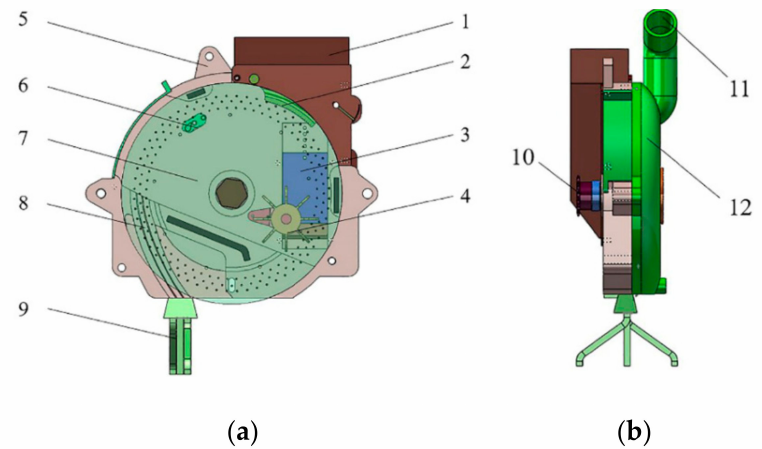
Figure 2. Structural diagram of the metering device: ( a ) Front view; ( b ) Lateral view. 1. Seed box, 2. Outer seed-cleaning device, 3. Retaining tray, 4. Seed stirring wheel, 5. Front housing, 6. Inner seed-cleaning device, 7. Metering tray, 8. Diversion channel, 9. Diversion tube, 10. Sprocket wheel, 11. Vacuum pressure outlet, 12. Rear